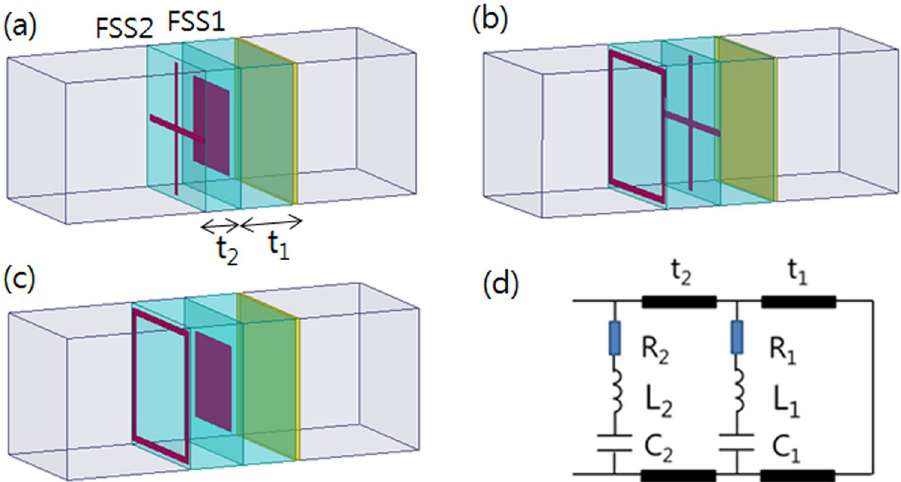
Figure 5. Schematic of the double-layered FSS absorbers with a combination of FSS1/FSS2: ( a ) square patch/ cross, ( b ) cross/square loop, ( c ) square patch/square loop, and ( d ) equivalent circuit.